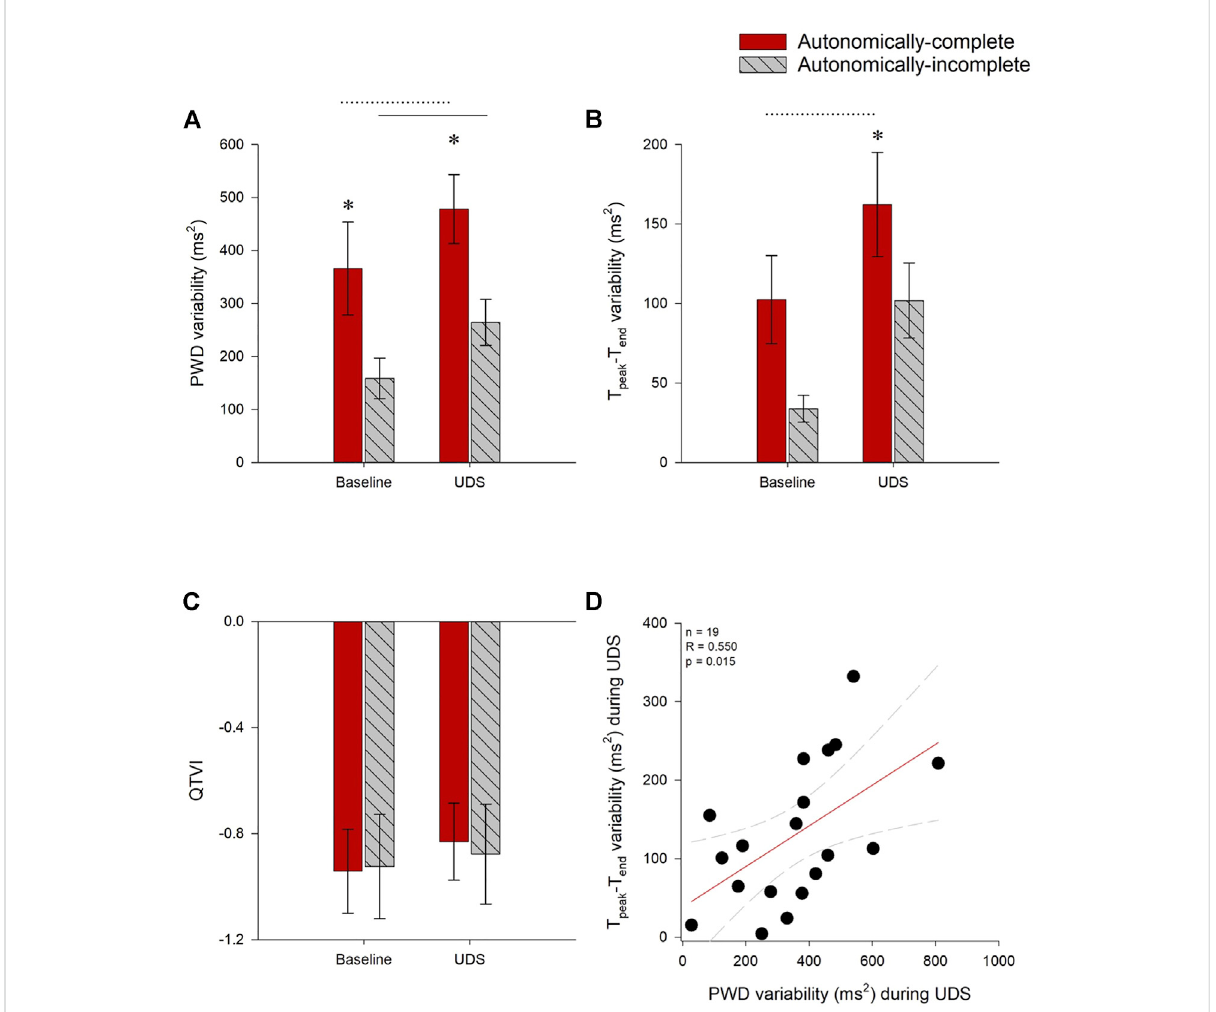
FIGURE 5 Impact of autonomic injury on electrocardiographic predictors of cardiac arrhythmia at baseline and during UDS. (A) P-wave duration (PWD) variability was increased in those with autonomically-complete injuries compared to those with autonomically-incomplete lesions, both at baseline ( p = 0.017) and during UDS ( p = 0.005). PWD variability was also increased compared to baseline in both autonomically-complete ( p < 0.001) and autonomically-incomplete ( p = 0.008) groups. (B) Tpeak-Tend interval (T peak -T end ) variability tended to be increased in those with autonomically-complete lesions at baseline, but this did not quite meet criteria for statistical signi fi cance ( p = 0.055). Tpeak-Tend interval variability was signi fi cantly increased during UDS in those with autonomically-complete ( p = 0.021) compared to autonomically-incomplete injuries. T peak - T end variabilityalso increasedinautonomically-completeinjuries duringUDScompared tobaseline ( p =0.01). (C) QTVIwasnotdifferentbetweenor withingroups( p > 0.05). (D) DuringUDS,increasedPWDvariabilitywascorrelatedwithincreasedT peak -T end variability(r=0.550, p =0.015).Statistical signi fi cance: * denotes statistical difference between groups; dashed line (---) denotes changes over time in autonomically-complete group; solid line ( – ) denotes changes over time in autonomically-incomplete group. Abbreviations: UDS, urodynamics testing; PWD, p-wave duration; T peak - T end , Tpeak — Tend interval; QTVI, QT variability